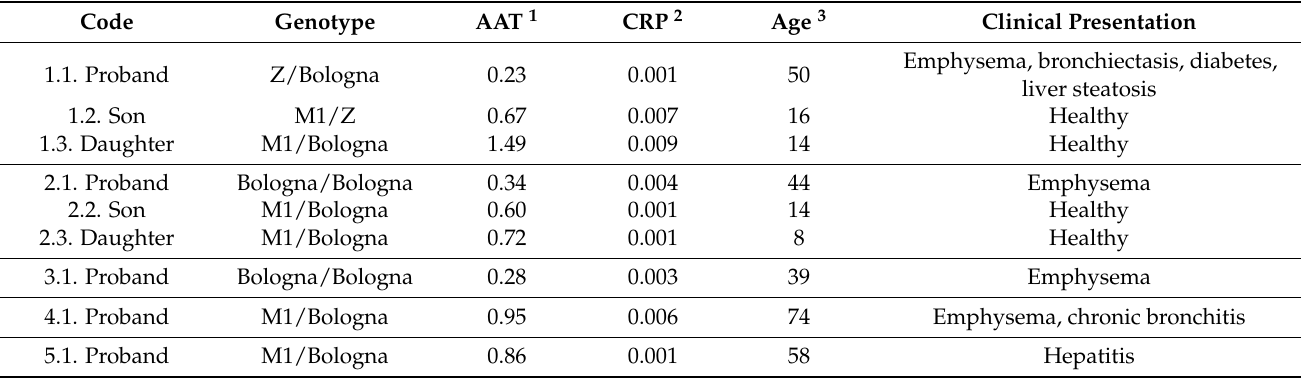
Table 1. Proband carriers of the Bologna variant and their